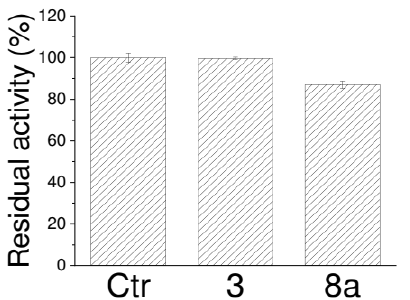
Figure 4. Dilution assay. To evaluate the mechanism of action of the compounds, a reversibility assay was carried out. The PTP1B was incubated in the presence of the saturating concentration of each compound (50 µ M) for 1 h at 37 ◦ C. Then, an aliquot of enzyme was diluted 500 folds in the assay buffer to evaluate the residual activity of the enzyme. Tests were carried out in triplicate. Data represent the mean value ±